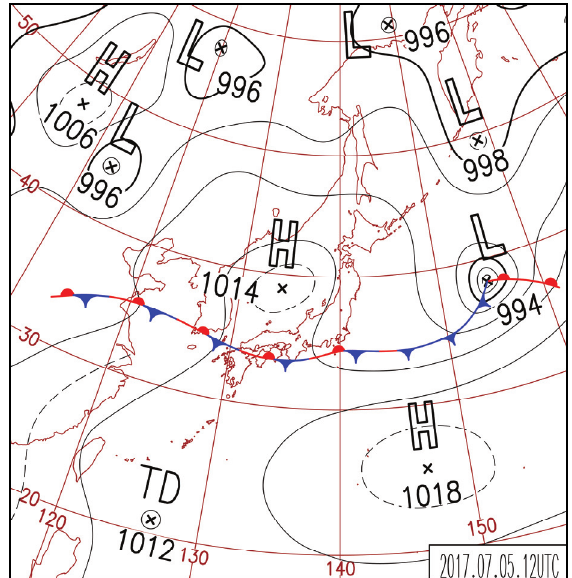
Figure 2. JMA weather chart (12:00 July 5, 2017).